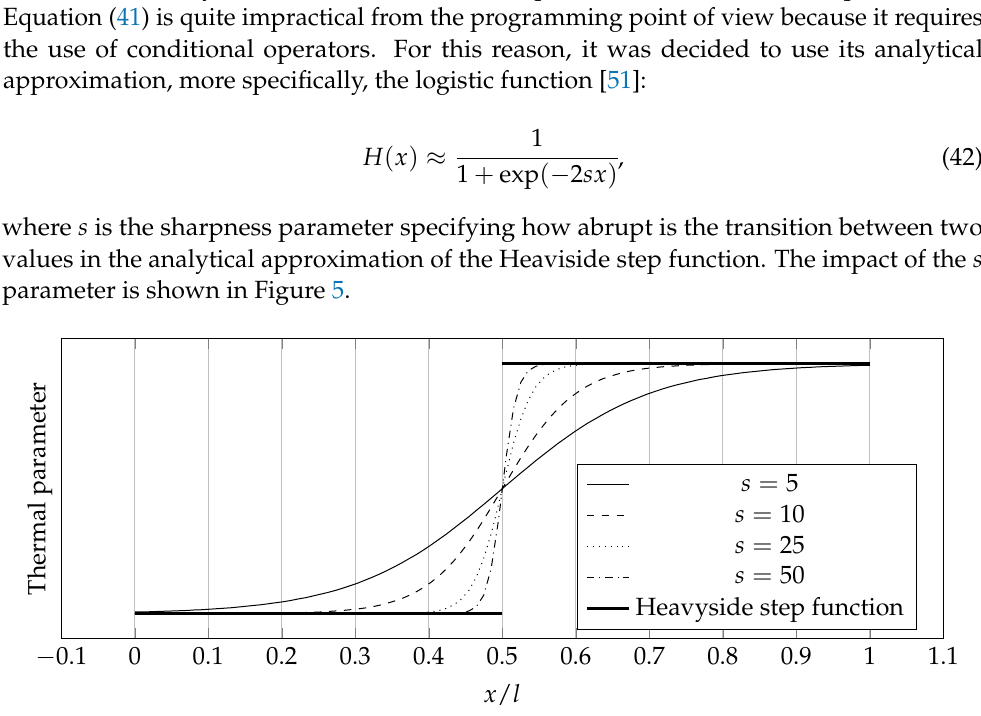
Figure 5. Discontinuous distribution of thermal parameters modeled using an analytical approximation of the Heaviside step function in the form of the logistic function for various values of s